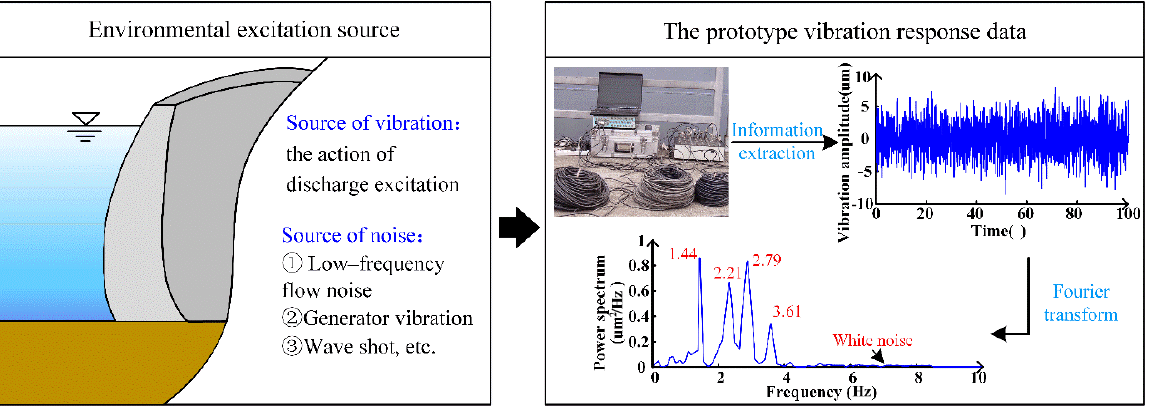
Figure 1. Prototype vibration response of the arch dam.